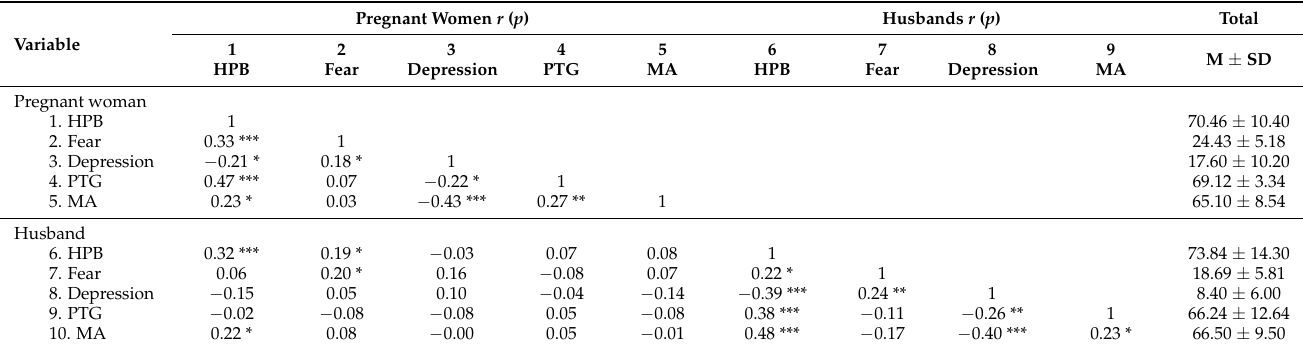
Table 1. Correlations among study variables ( N = 123 couples).